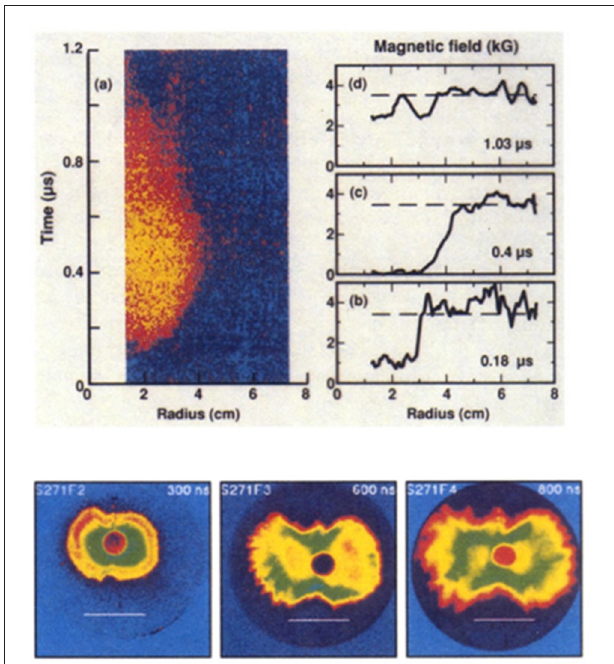
FIGURE 2 | Results of laser experiment by Dimonte and Wiley (1991) showing: [top] radius vs. time of the magnetic cavity from MIP measurements (left; blue region corresponds to the ambient magnetic field ∼ 4kG, orange to zero magnetic field) and (right) corresponding line-outs at various times showing well-developed cavity at t = 0.4 µ s. [bottom] False color images of expanding plasma cloud at various times (300, 600, 800 ns)–the two laser beams hit the target from the left and right sides of the picture and plasma expands outward producing short-wavelength modes on the surface. Here the magnetic field (out of the plane) is 3.5kG. The top panels are from Figure 3, bottom panels from Figure 2 in Dimonte and Wiley (1991). The figures are reproduced with permission from The American Physical